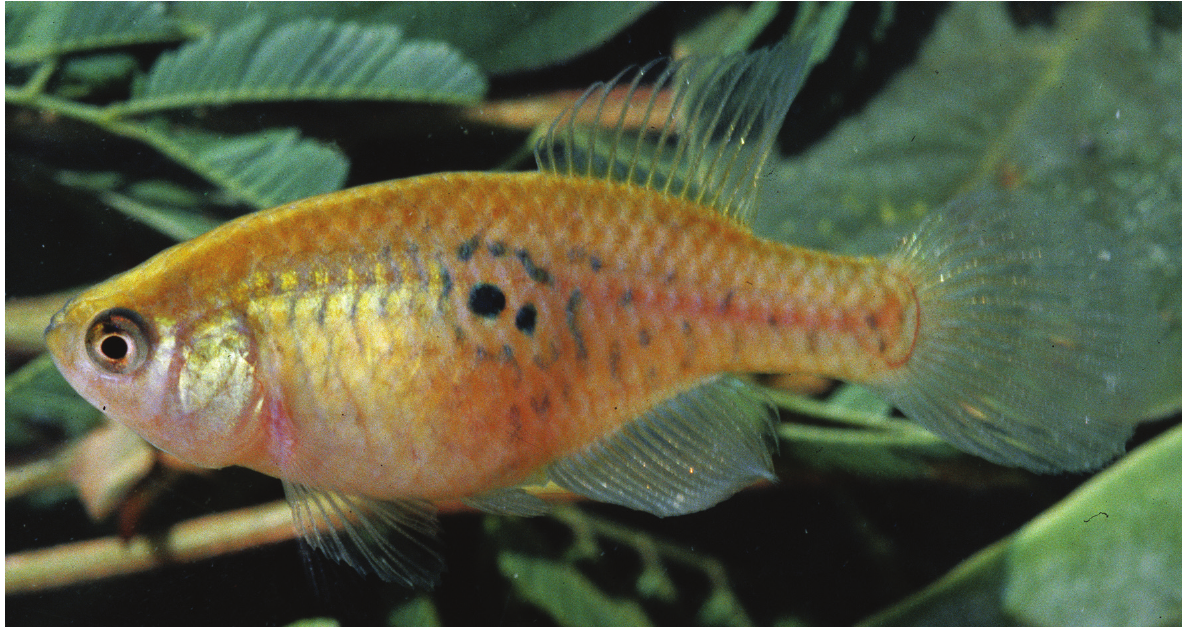
Figure 6. Hypsolebias fulminantis , UFRJ 4847, female, 34.0 mm SL. Photograph by W.J.E.M.